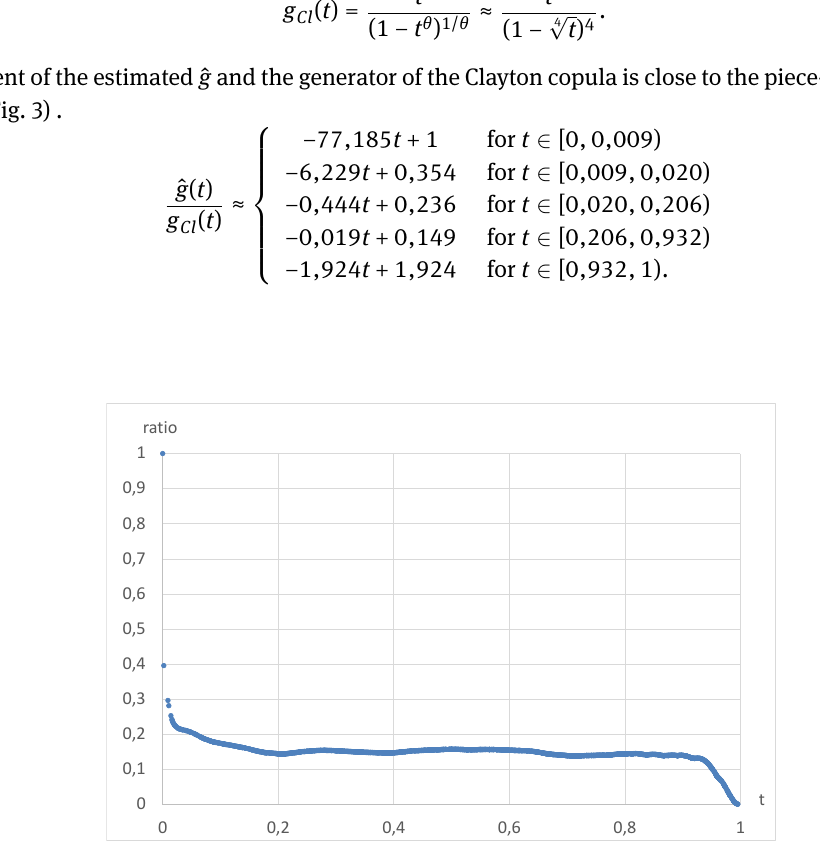
Figure 3: Ratio (cid:98) g ( t )/ g Cl ( t ) , θ =